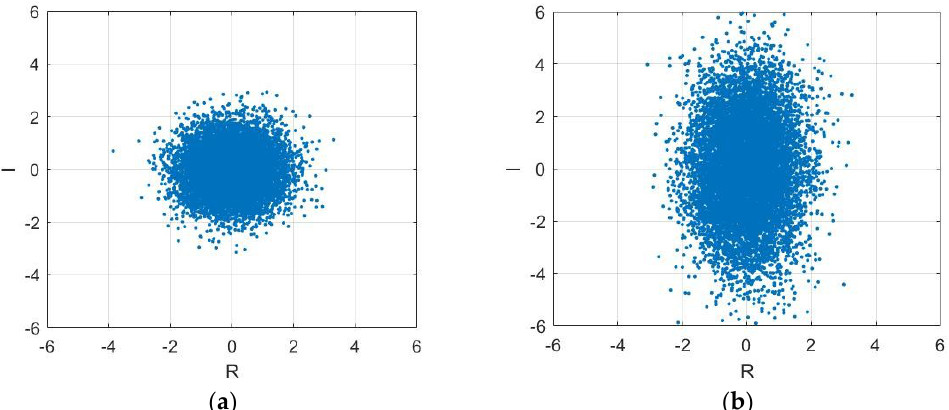
Figure 1. Scatter diagrams of the noncircular signal and circular signals: ( a ) circular signal; ( b ) noncircular signal.